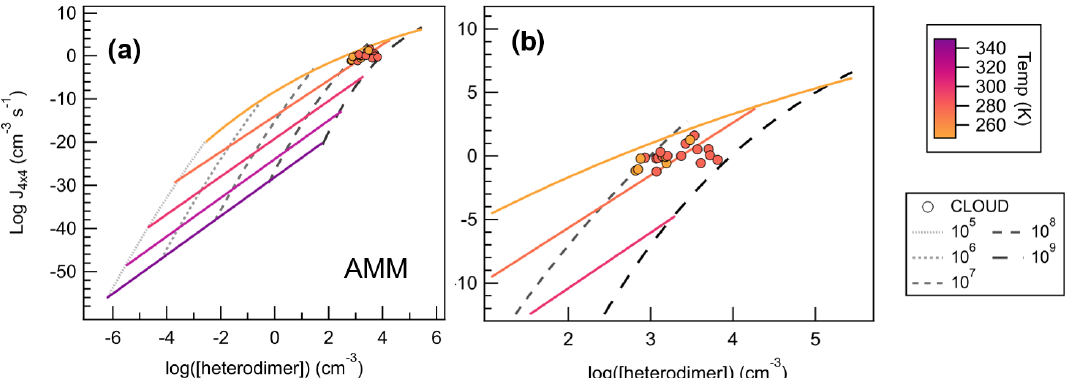
Figure 10. Heterodimer concentration plotted against J 4 × 4 for SA–AMM across 25 computational conditions (filled diamonds) from 248– 348K and monomer concentrations from 10 5 –10 9 cm − 3 , where panel (a) shows the full set of conditions calculated for SA–AMM, and panel (b) shows a magnification of how CLOUD data compare to the computational dataset. Colored lines correlate to temperature trendlines that were drawn through all data points calculated at the same temperature. Dashed lines represent data points calculated at the same monomer concentrations. We calculated heterodimer concentrations for CLOUD data whose acid and base concentrations were within 50% of each other according to Eq. (3). All CLOUD data points were collected at temperatures of either 248 or 273K (colored circles corresponding to color scale) and with monomer concentrations between approximately 10 8 –10 9 cm − 3